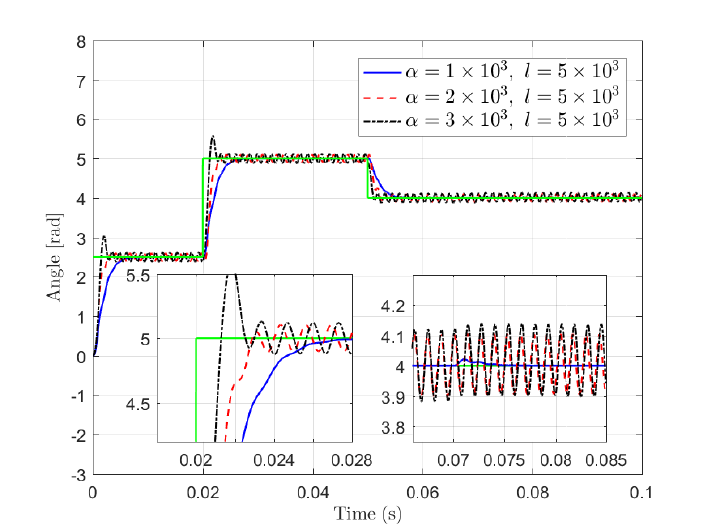
Figure 3. Transient and disturbance rejection performance of ROPIO compensated ROMBC